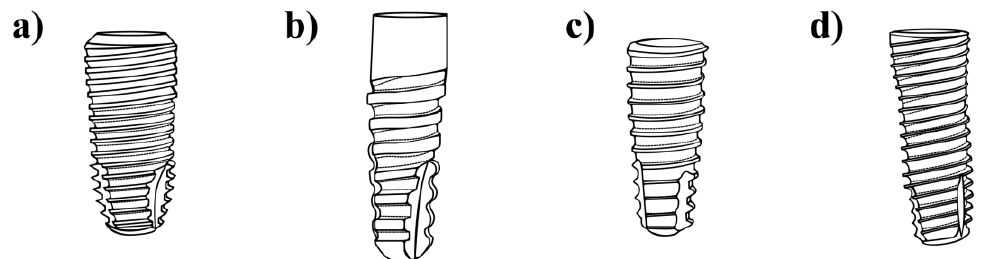
Figure 1. Schematic representation of the dental implants used in the study: ( a ) Sample 1, ( b ) Sample 2, ( c ) Sample 3, and ( d ) Sample 4.